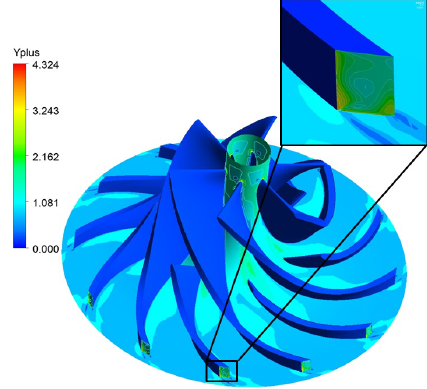
Figure 6. The y + contour on hub and blade surface with K- omega turbulence model. The blade trailing edge region is zoomed in the inset figure to show the maximum y +